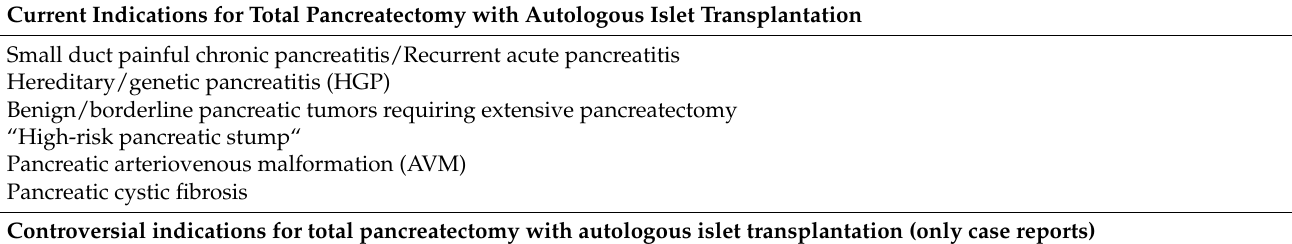
Table 1. Current indications for total pancreatectomy with autologous islet transplantation. Current Indications for Total Pancreatectomy with Autologous Islet Transplantation